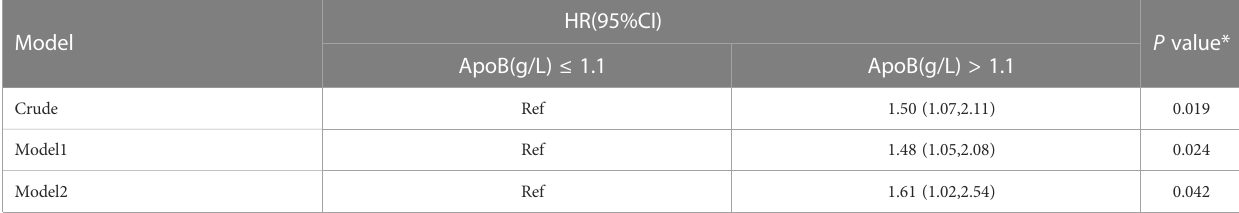
TABLE 4 Association between the baseline ApoB and incident of CKD in the longitudinal cohort.